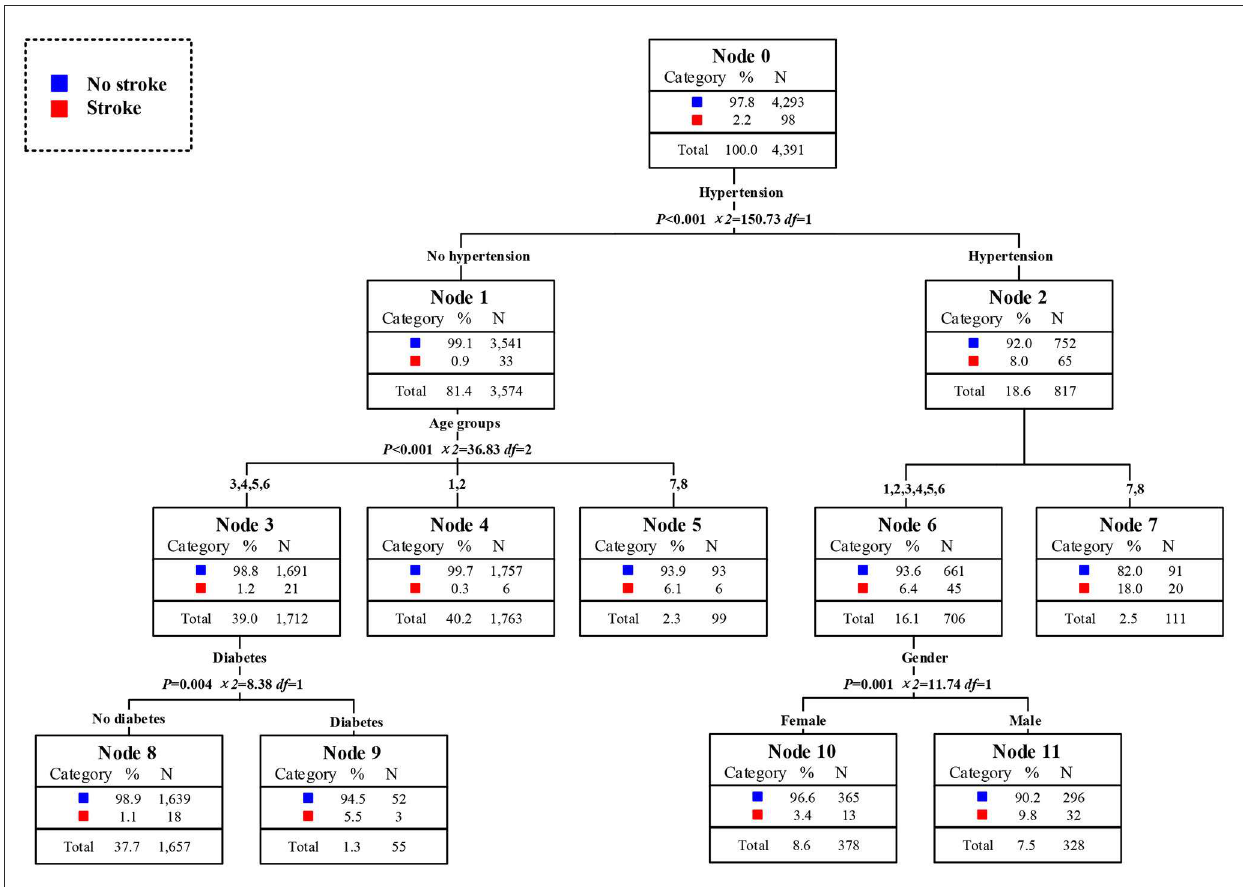
FIGURE7 Assessment of risk factors and the susceptible population of stroke in 2009.